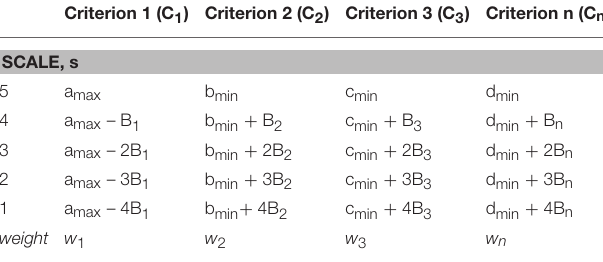
TABLE 1 | Generalized form of the decision